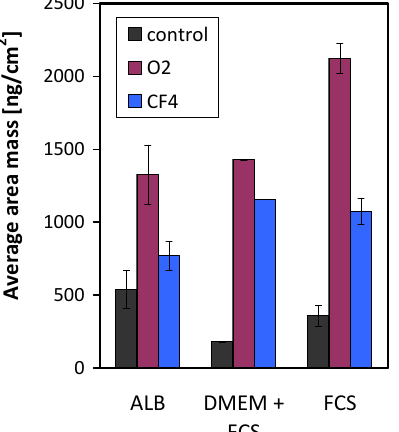
Figure 11. Mass of adsorbed proteins on untreated and plasma-treated